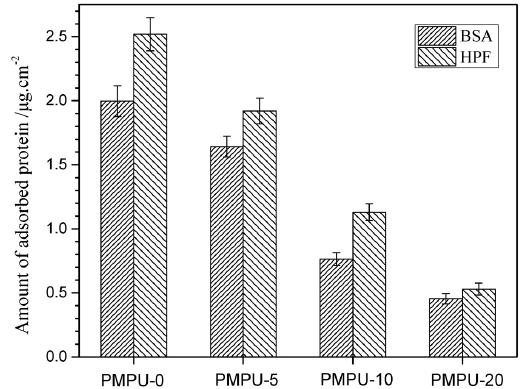
Figure 6. The amount of adsorbed protein on the surface of composite films with varying PMEH content at 37 ± 0.5 °C.